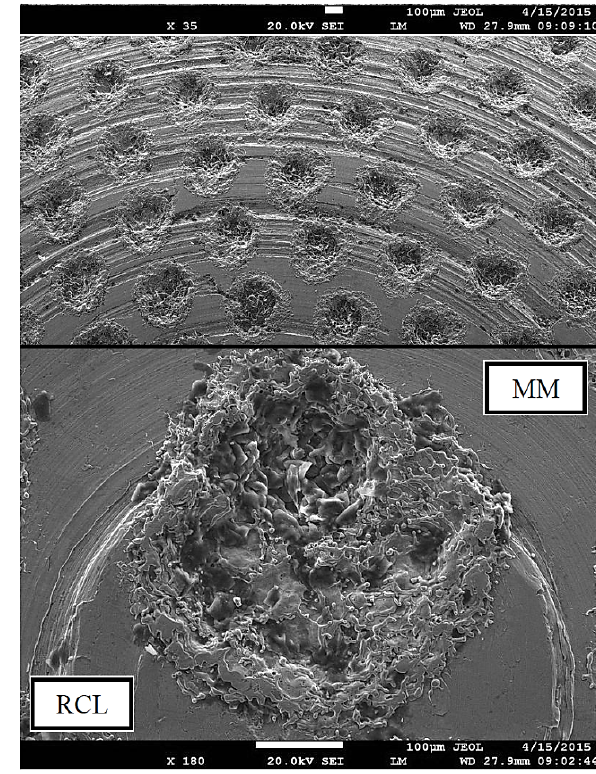
Figure 8: Hemispherical surface of sample III covered by texture